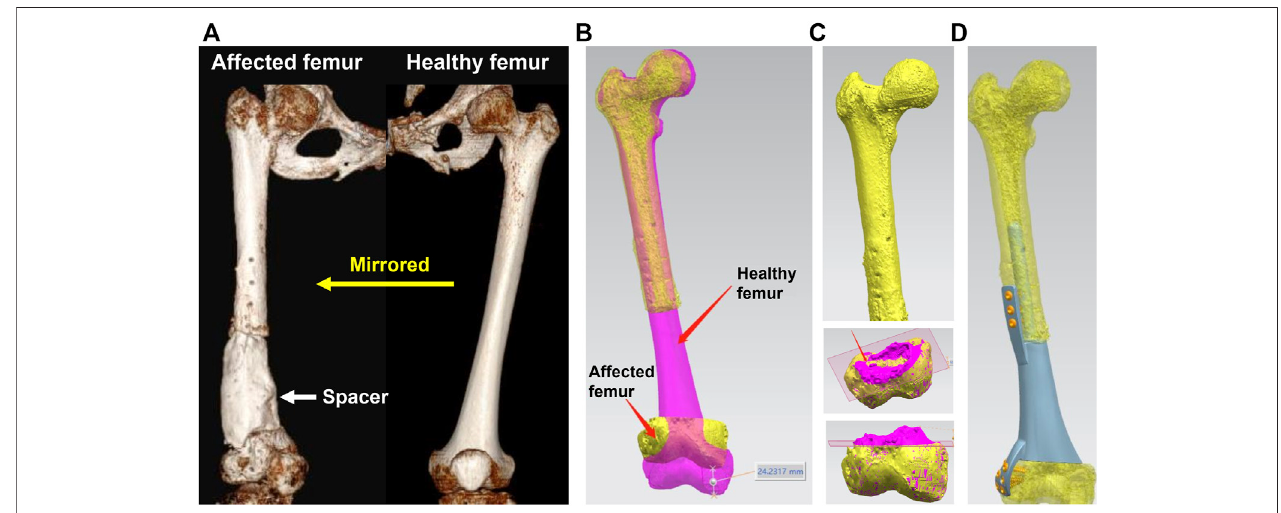
FIGURE1| Designprocessofa3Dprintedprosthesis. (A) 3DCTreconstructionofbilateralfemurs,thebonedefectwasoccupiedbyacementspacer,thehealthy femur was mirrored to the disease-affected side; (B) Overlapping femurs could reveal the size and shape of metaphyseal bone defect; (C) The overlapping 3D models could help to determine the osteotomy scope; (D) Simulation of the prosthesis insertion and internal fi xation.